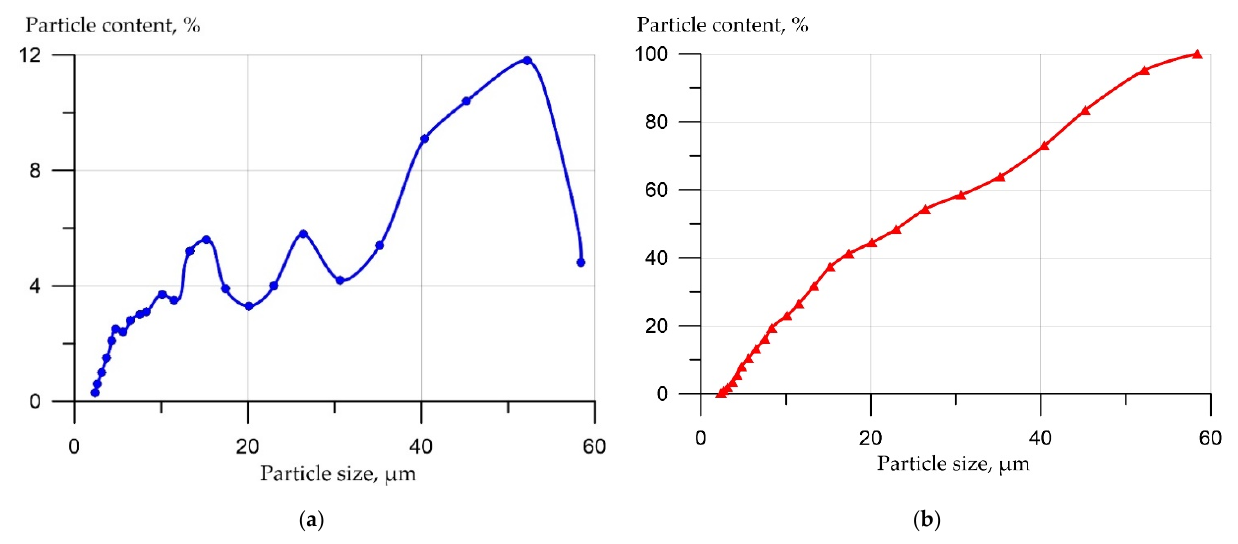
Figure 2. River snail shell powder particle size distribution curve: ( a ) particle distribution; ( b ) cumulative curve. Table 3. Dosage of the nanomodifying additive.